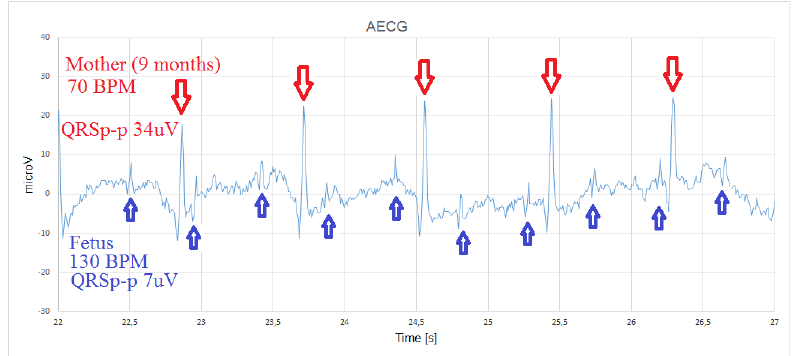
Figure 10. Abdominal ECG recorded in the ninth month of pregnancy with the sensor positioned in the center of the abdomen, 5 cm below the